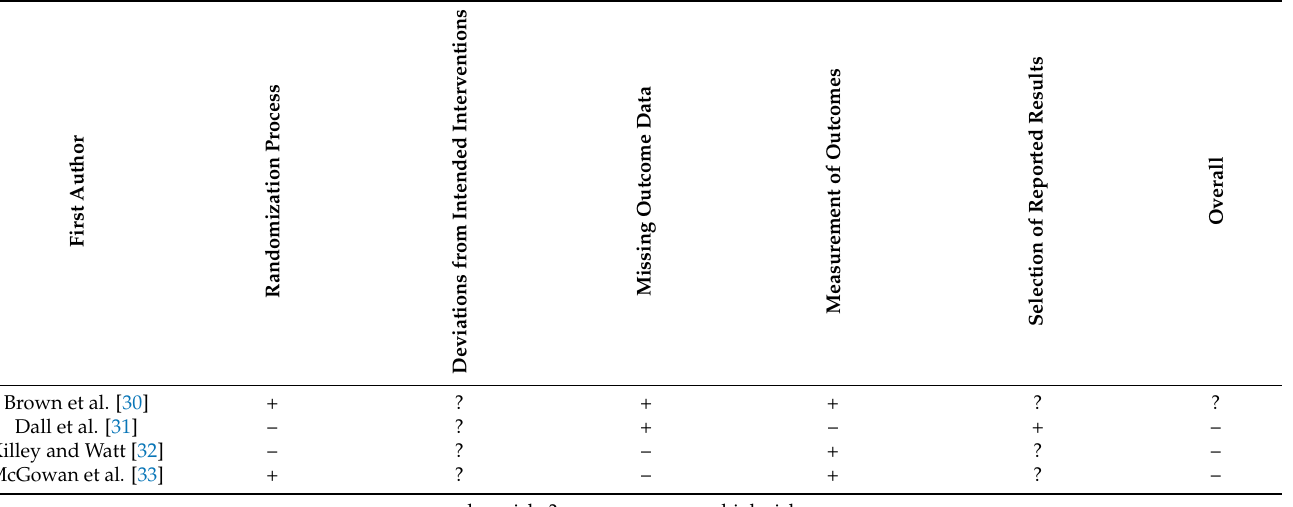
Table 2. Risk of bias-2 scores of the included studies.